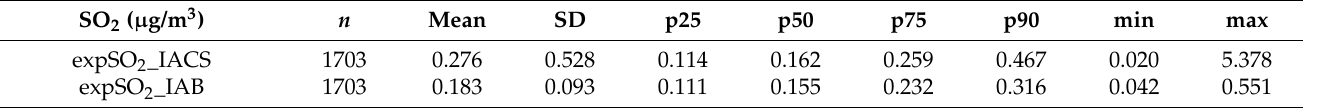
Table 2. Subjects ’ exposure distribution for exposure to sulfur dioxide (SO 2 ) emitted by both Indus- trial Area of Central Salento (IACS) and Industrial Area of Brindisi (IAB).